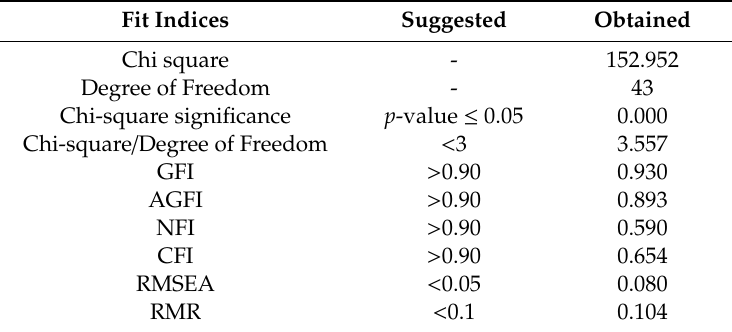
Table 18. Fit indices and their acceptable thresholds in SEM.